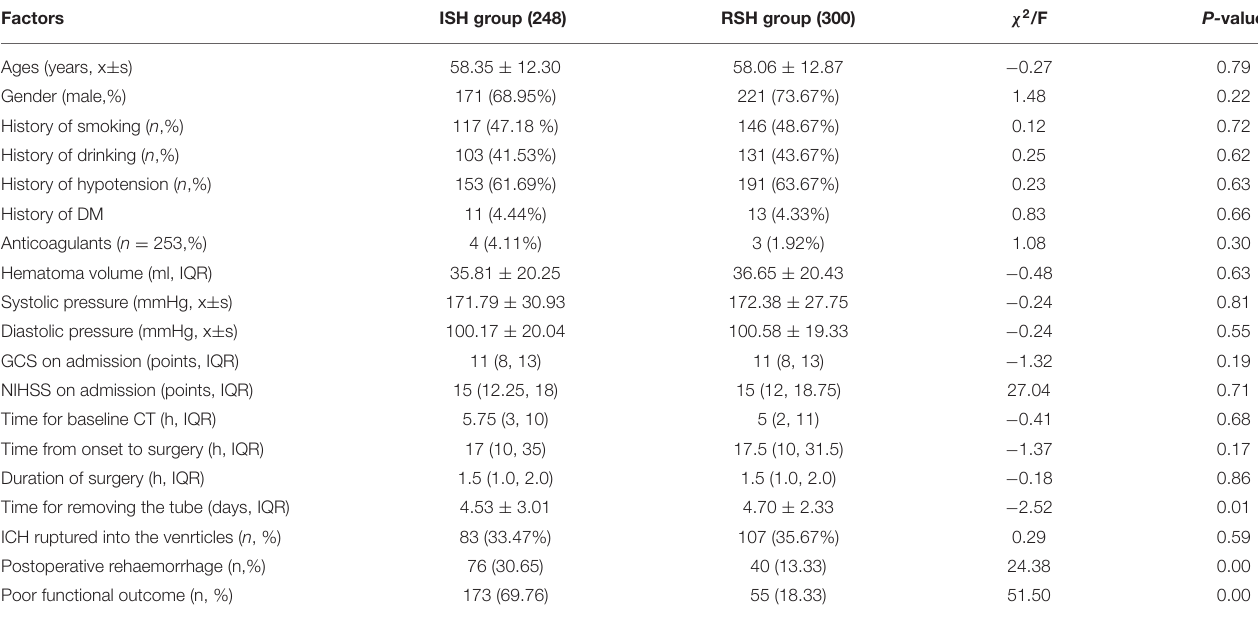
TABLE 1 | Comparison of baseline data between regular-shaped and irregular-shaped hematoma